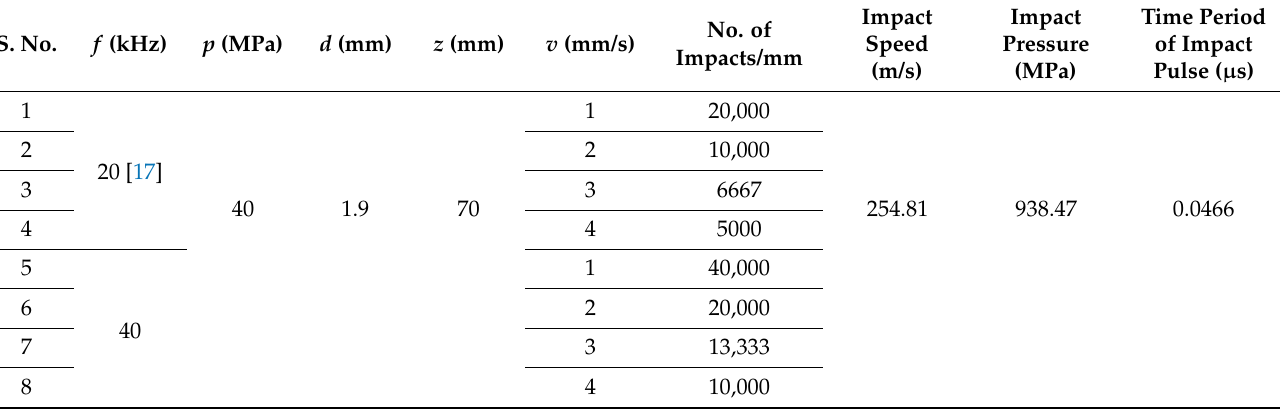
Table 3. Experimental